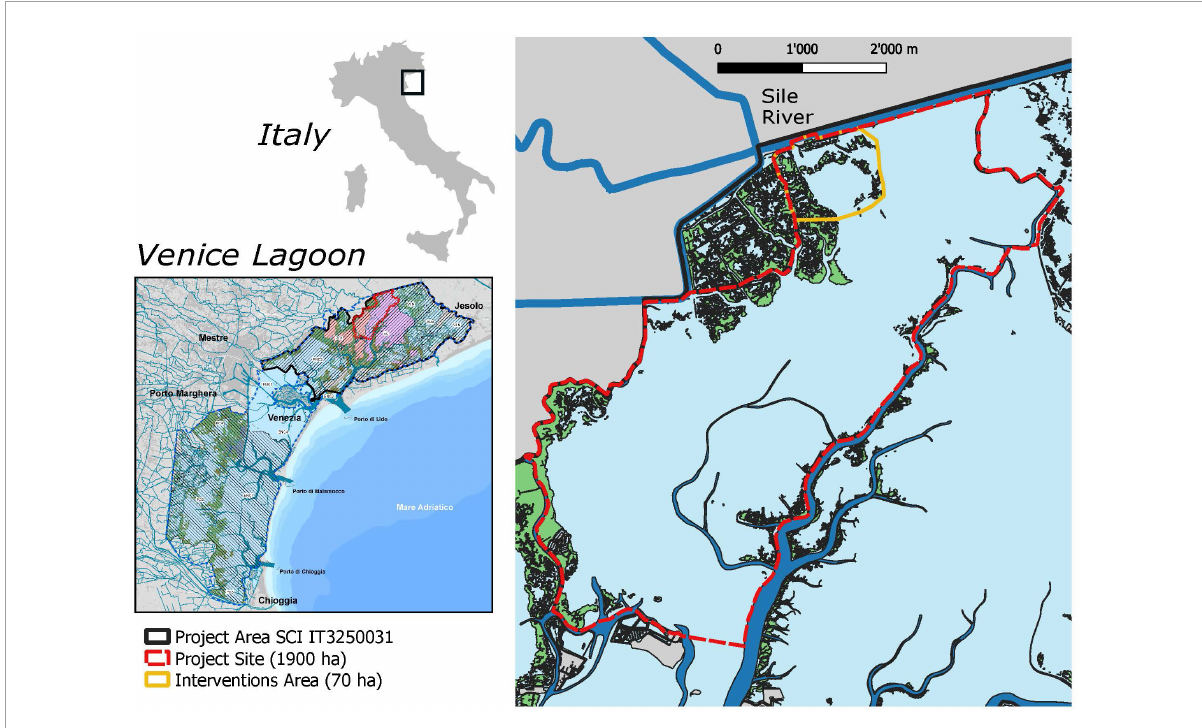
FIGURE1 Project area, project site, and interventions area of the life lagoon refresh